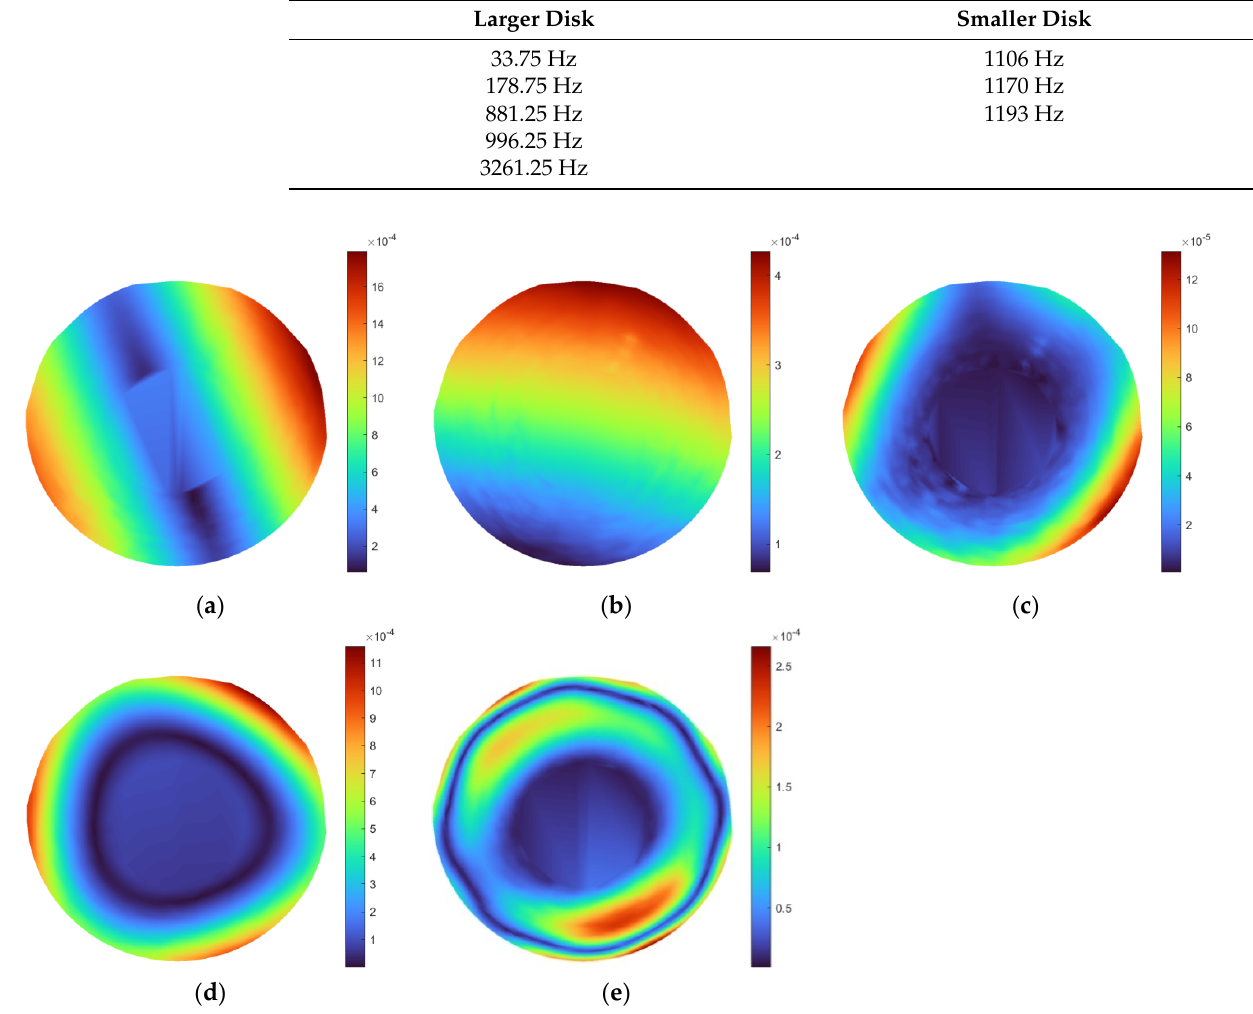
Figure 8. The interpolated mode shapes of the larger disk: ( a – e ) subsequent considered mode shapes.